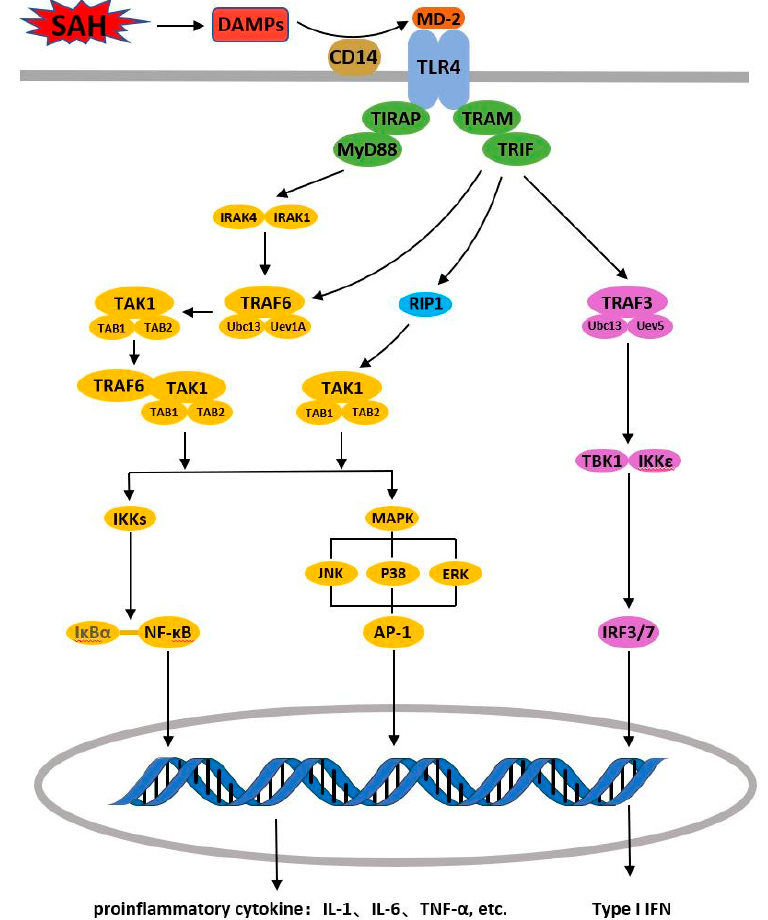
Figure 1. The MyD88 dependent and independent